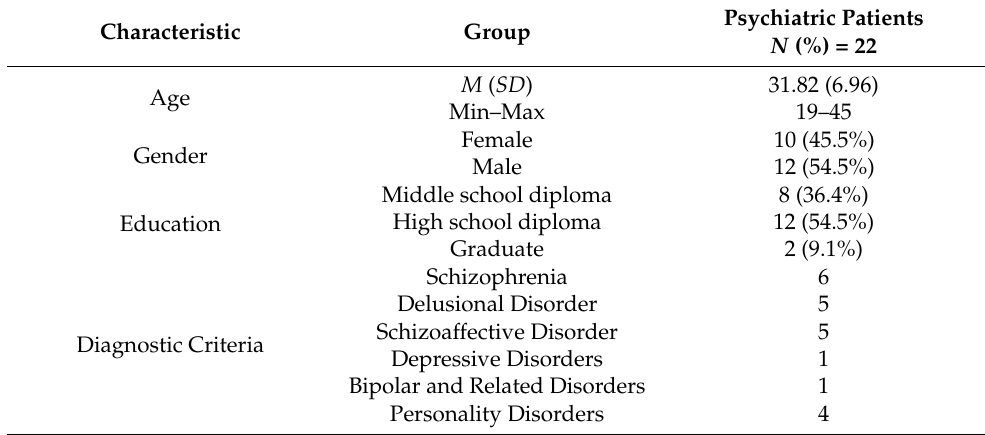
Table 1. Descriptive statistics of the study